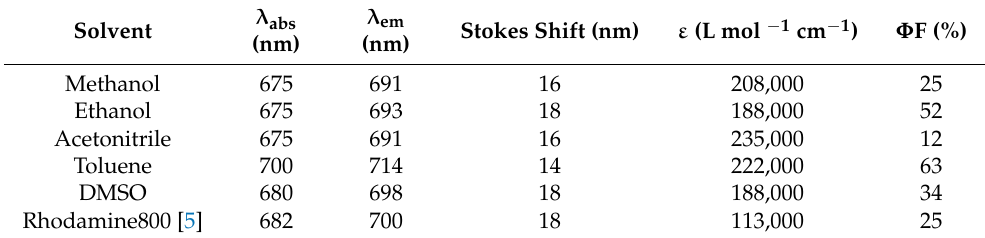
Figure 1. ( a ) The absorbance spectra of compound 5 in methanol at different concentrations (0.5, 1.0, 1.5, 2.0, 2.5, and 3.0 µ M). ( b ) Linear curve demonstrating Beer–Lambert Law used to determine molar Table 2. Optical properties of compound 5